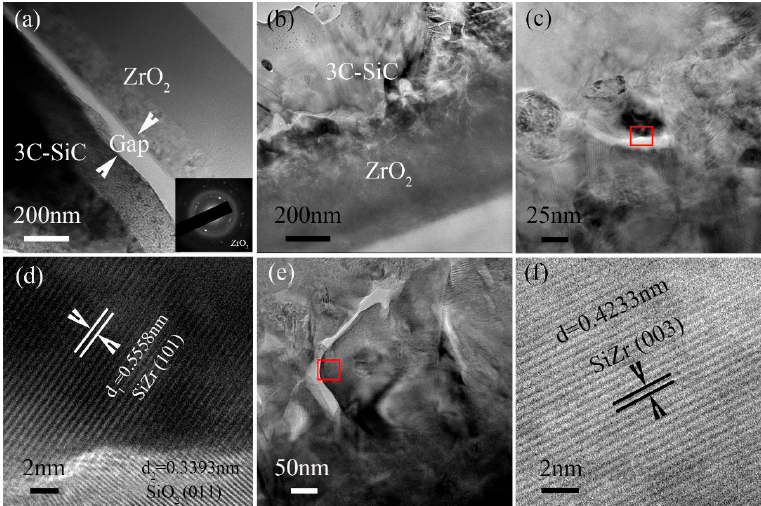
Figure 7. Cross-sectional bright field TEM images of the annealed 3C-SiC/ZrO 2 thin films, ( a ) Microstructure of T-3C-SiC/ZrO 2 thin film; ( b – f ) Microstructure of O-3C-SiC/ZrO 2 thin film; ( d ) and ( f ) HRTEM images of the areas indicated by red rectangles in ( c , e ), respectively.